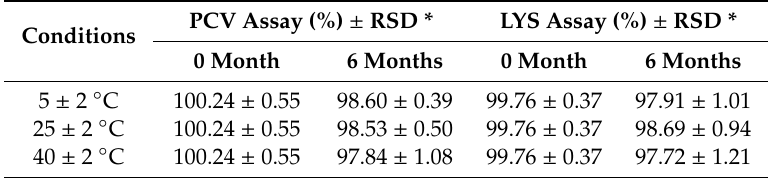
Table 3. Analysis of PVC-LYS content in formulations subjected to accelerated stability